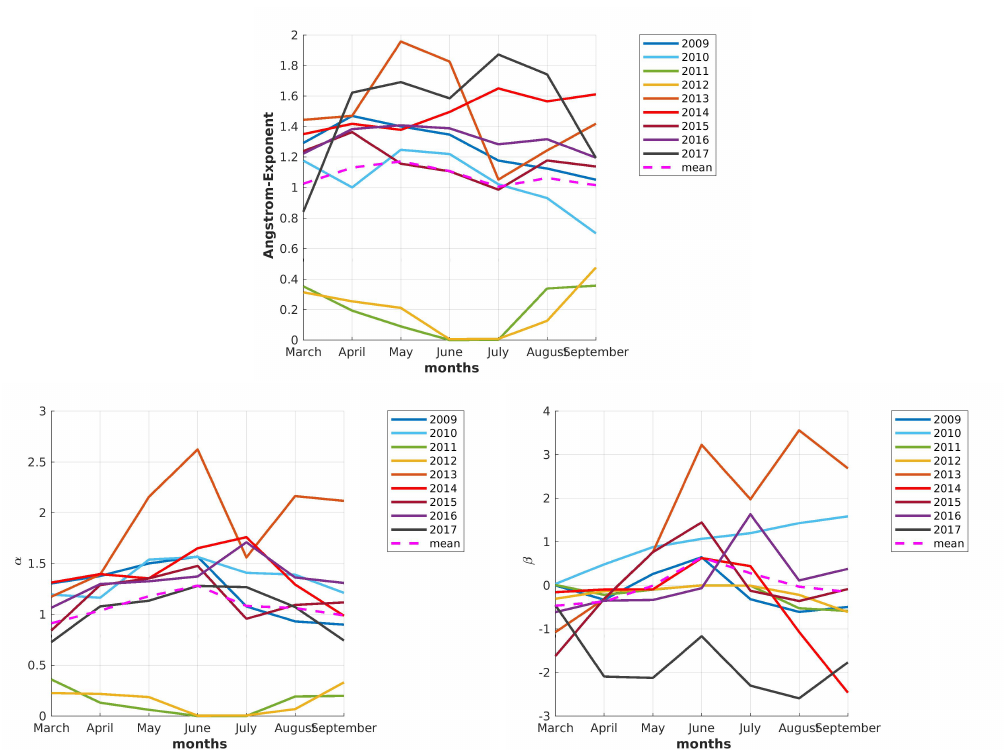
Figure A2. Trend of the traditional and modified Ångström exponents AE (upper row), α , and β (lower row) for the years